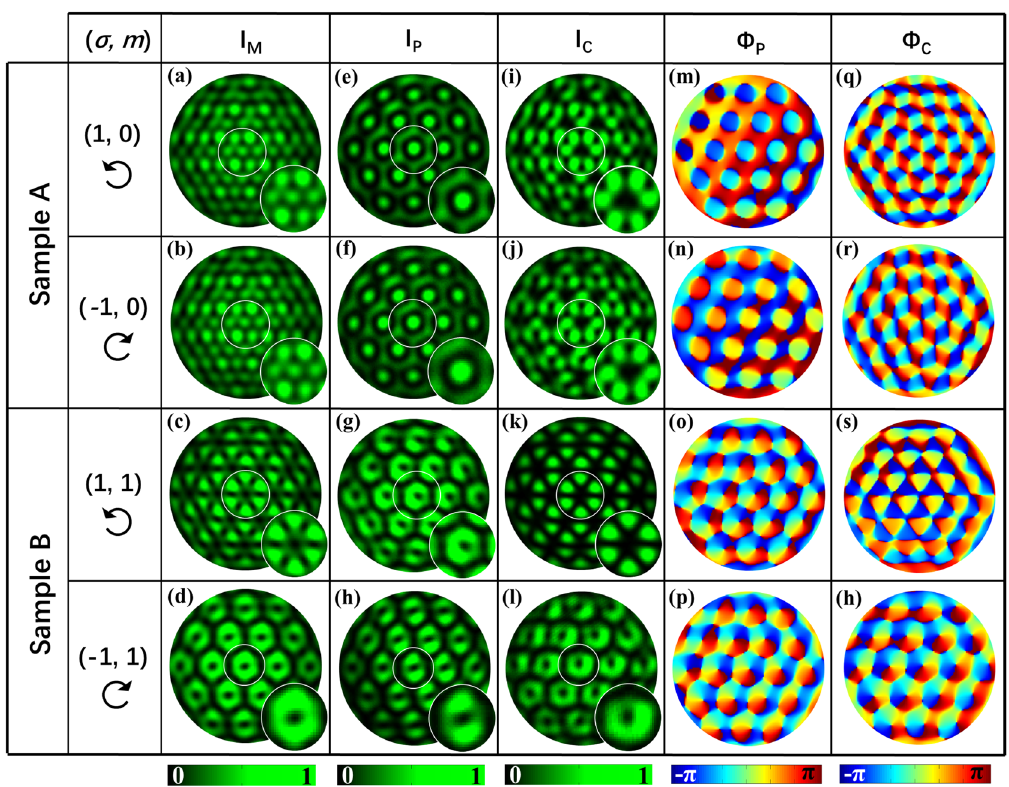
Figure 3: Experimental results for samples A and B under illumination of LCP and RCP light: (a) – (d) Measured intensity patterns for the overlapping lattices of the mixed spin components ( I M ). (e) – (h) and (i) – (l) Measured intensity distributions for the primary spin components ( I P )andconvertedspincomponents( I C ),respectively,andtheenlargedviewsofthecenterlatticeunit,labeledinwhitecircles,areshowninthe insets. (m) – (p) and (q) – (h) Experimental phase maps ( Φ P and Φ C ) corresponding to the two spin components. All the black open circle arrows represent the polarization of the incident results in Figure 3 and the simulated results in Figure 2.